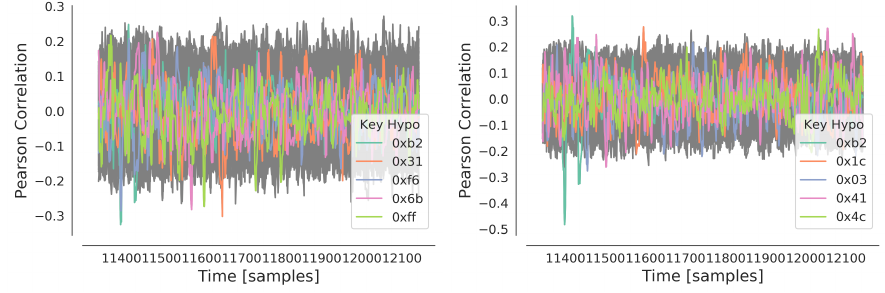
Figure 35: Pearson Correlation coefficients in Step 3 (byte 0) with traces 242-498 (left) and traces 114-370